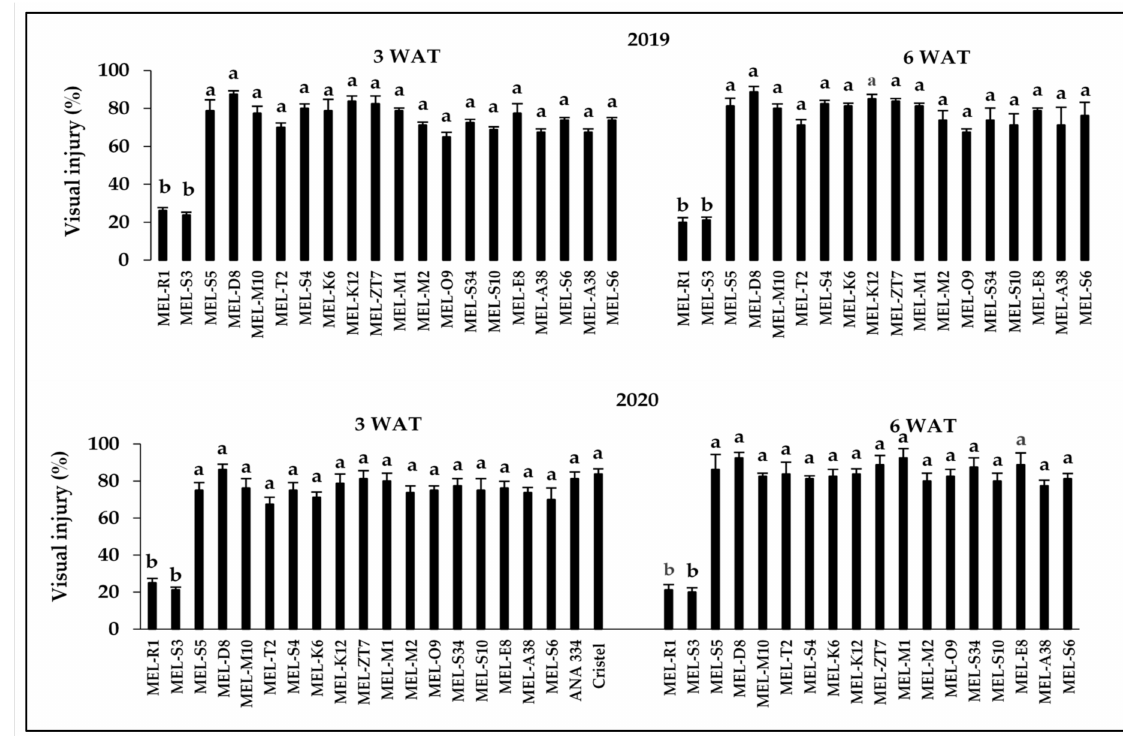
Figure 3. Response of melon accessions and commercial cultivars to 2,4-D application at the rate of 112.1 g ae ha − 1 3 and 6 weeks after treatment during 2019 and 2020. Means in each chart followed by different letters are significantly different at p ≤ 0.05 using LSD